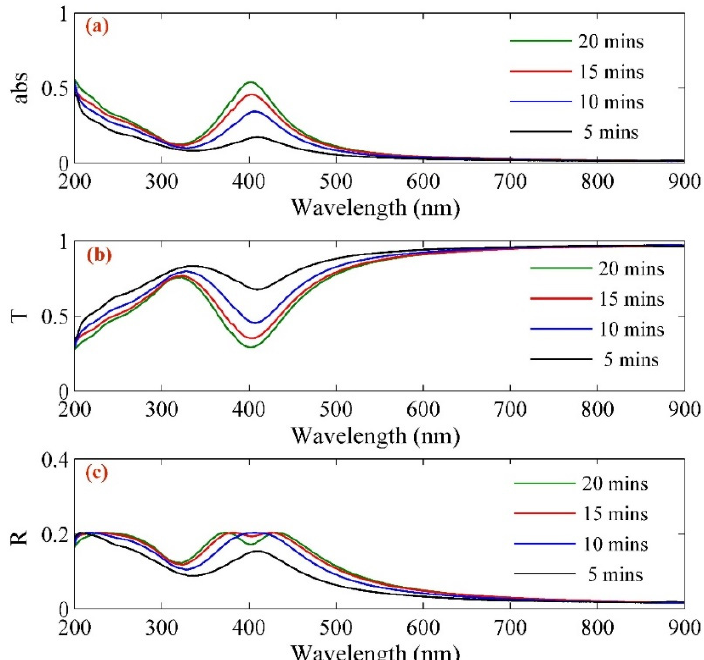
Figure 4. ( a ) absorbance, ( b ) transmissivity, and ( c ) reflectance of Ag–NPs/CD in different ablation time.